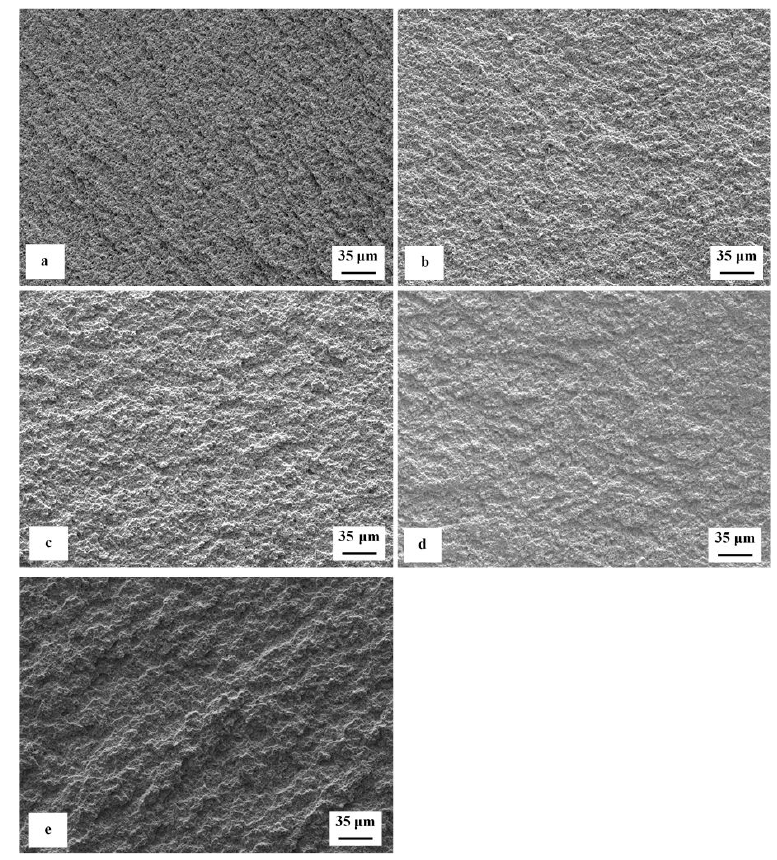
Figure 7. Representative SEM micrographs of the fracture surfaces of sub-zero treated specimens after flexural strength testing, ( a ) tempered at 170 °C, ( b ) tempered at 330 °C, ( c ) tempered at 450 °C, ( d ) tempered at 530 °C, and ( e ) tempered at 600 °C.